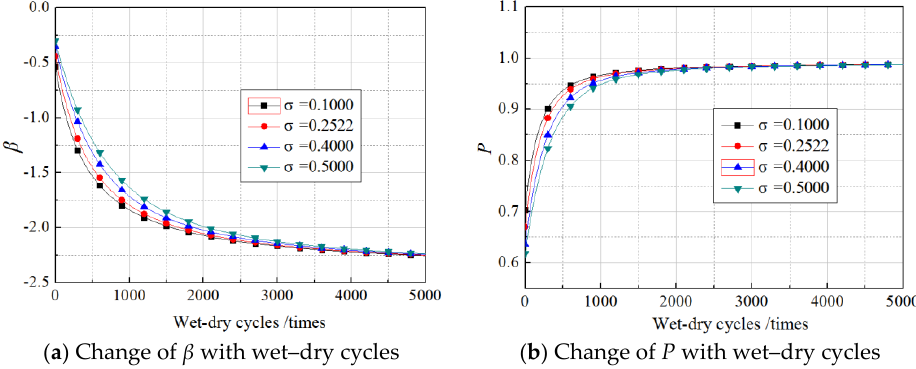
Figure 11. The effects of standard coefficients of the load on the 60% sustained loading specimens.